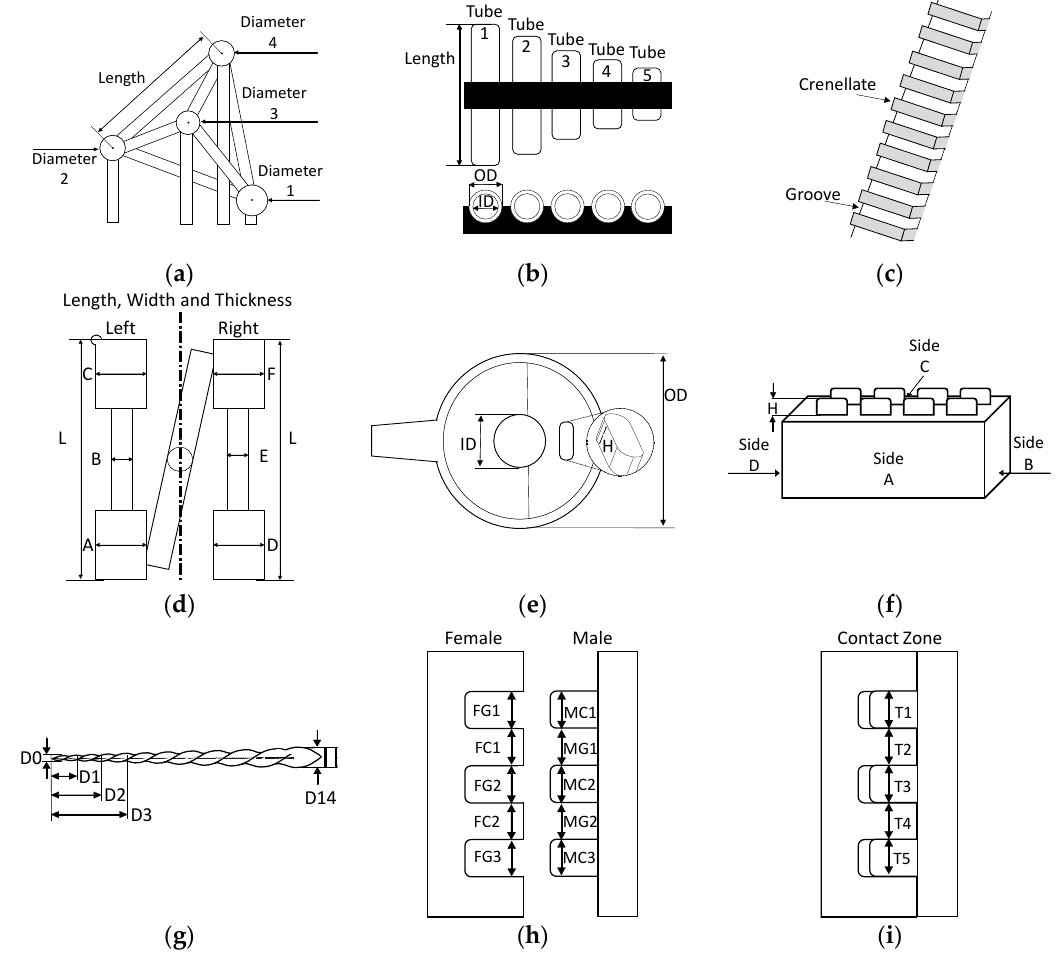
Figure 5. Work piece dimensions: ( a ) CT Tetrahedron, ( b ) Pan Flute, ( c ) Step Gauge, ( d ) Dog bone, ( e ) Toggle, ( f ) Lego, ( g ) Endodontic file, ( h ) male and female in TEF-POM and TEF-PVC, and ( i ) contact zone in TEF-POM and TEF-PVC.